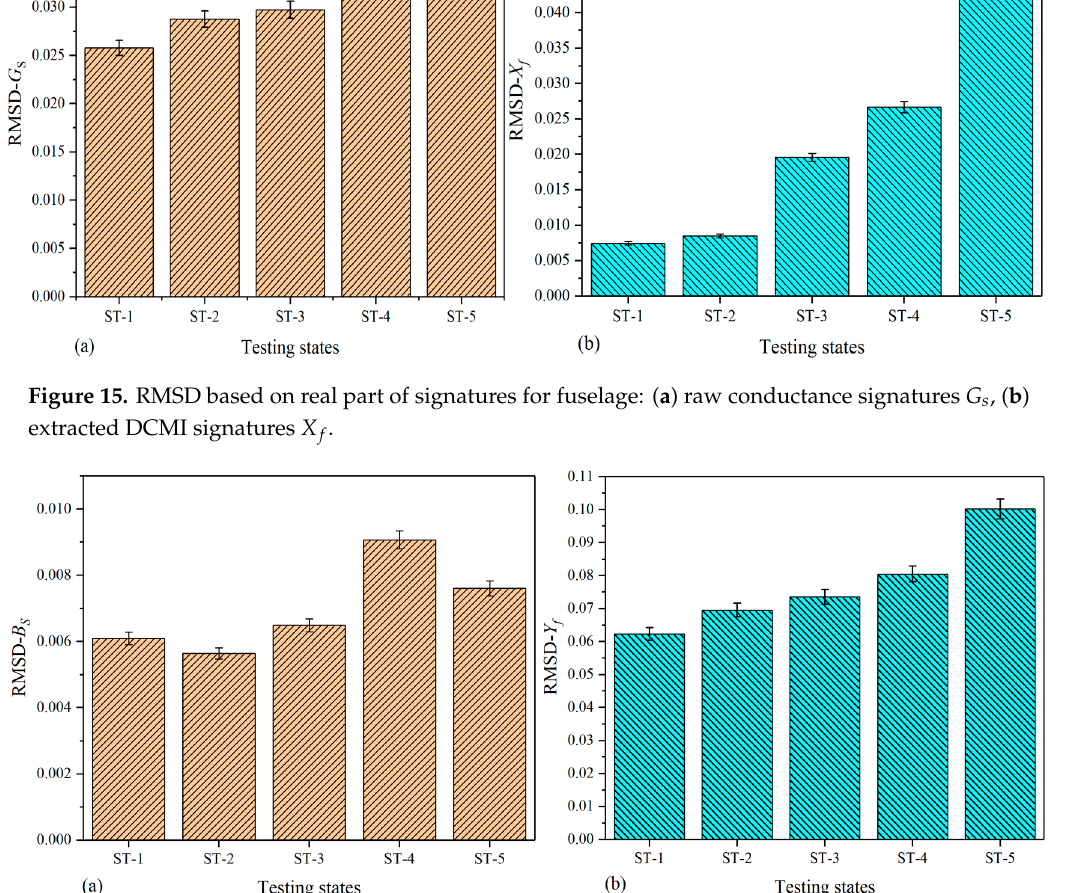
Figure 15. RMSD based on real part of signatures for fuselage: ( a ) raw conductance signatures ( b ) extracted DCMI signatures